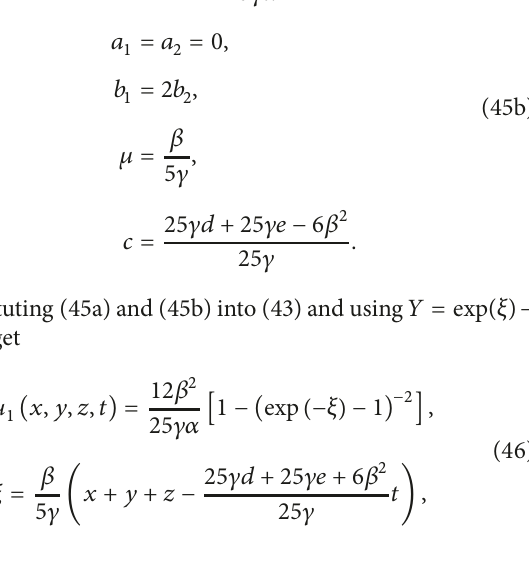
Figure 2: Solitary wave profile of 𝑢 3 , 𝛼 = 1 , 𝑑 = 0.5 , 𝑒 = 0.5 , 𝑐 = 0.6 , 𝑥 = 0 , and 𝑡 = 0.5